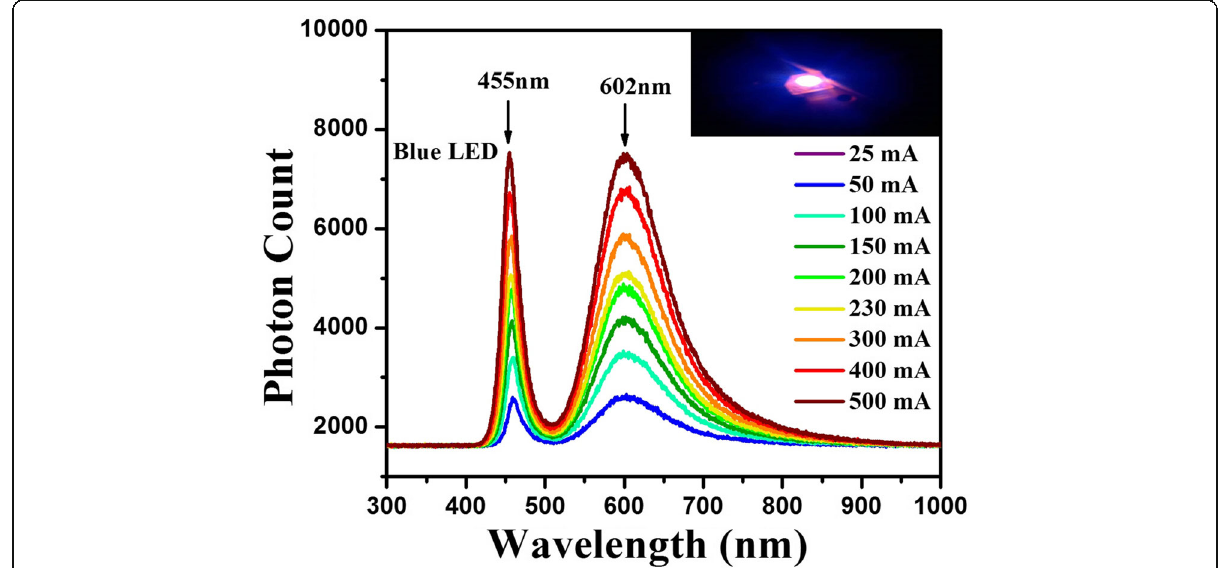
Fig. 6 Emission spectra of green (G)-, yellow (Y)-, and orange (O)-emitting ZnInS:Cu/ZnS CNCs integrated on LED driven at varying current injection